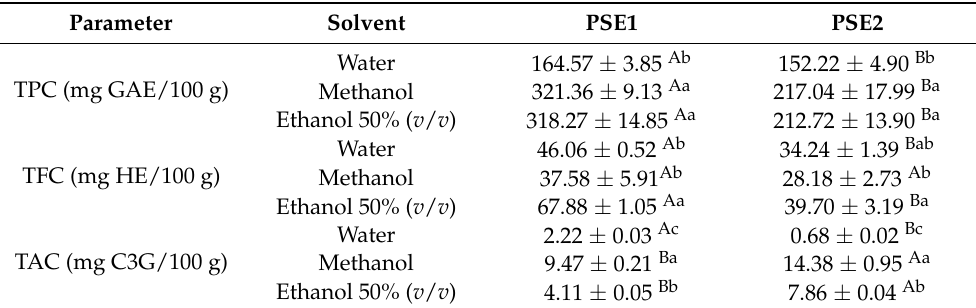
Table 1. Total phenolic (TPC), total flavonoid (TFC) and total anthocyanin (TAC) contents of black- thorn fruit